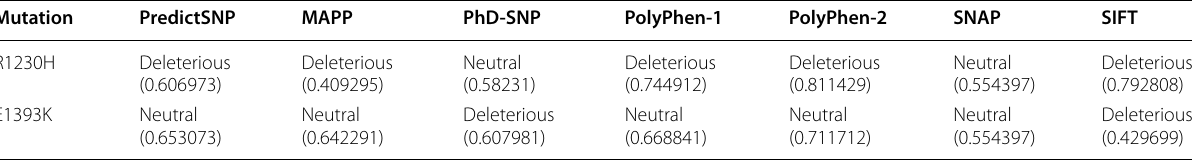
Table 7 Evaluation of the deleteriousness of nsSNPs by the predictSNP1.0 server based on many prediction tools